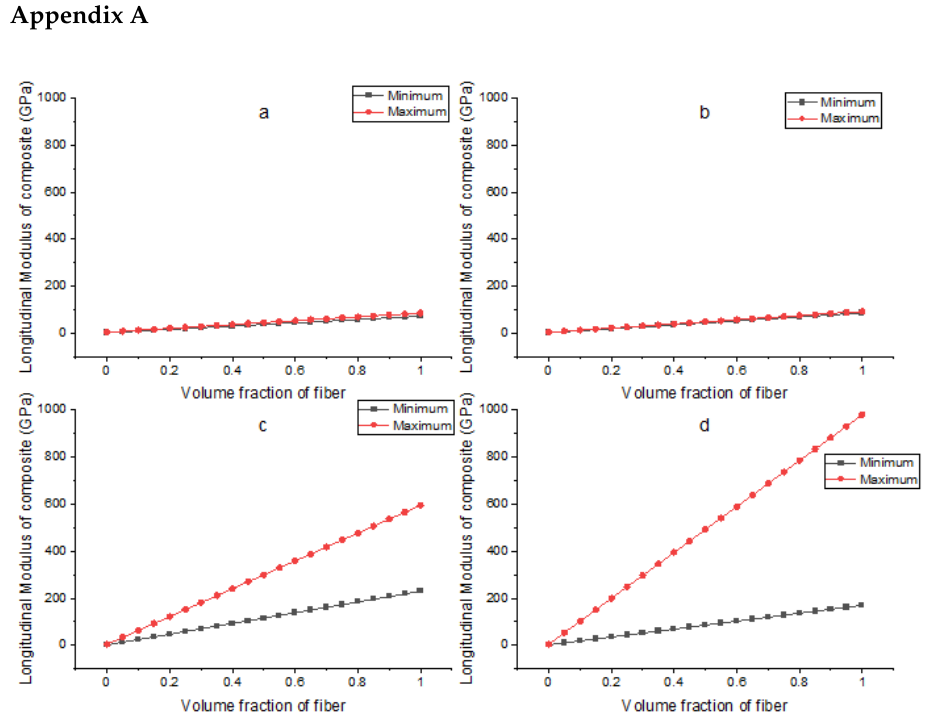
Figure A1. Depicts the variation in longitudinal modulus of ( a ) E-glass, ( b ) S-glass, ( c ) T300 carbon fiber and ( d ) AS carbon with volume of fiber. It can be seen that as the fiber ratio increases, the longitudinal modulus of all the materials increases. It is also noted that there is a linear increase in the modulus. For the carbon-fiber family, the increase in the modulus is far more compared to the glass-fiber family.